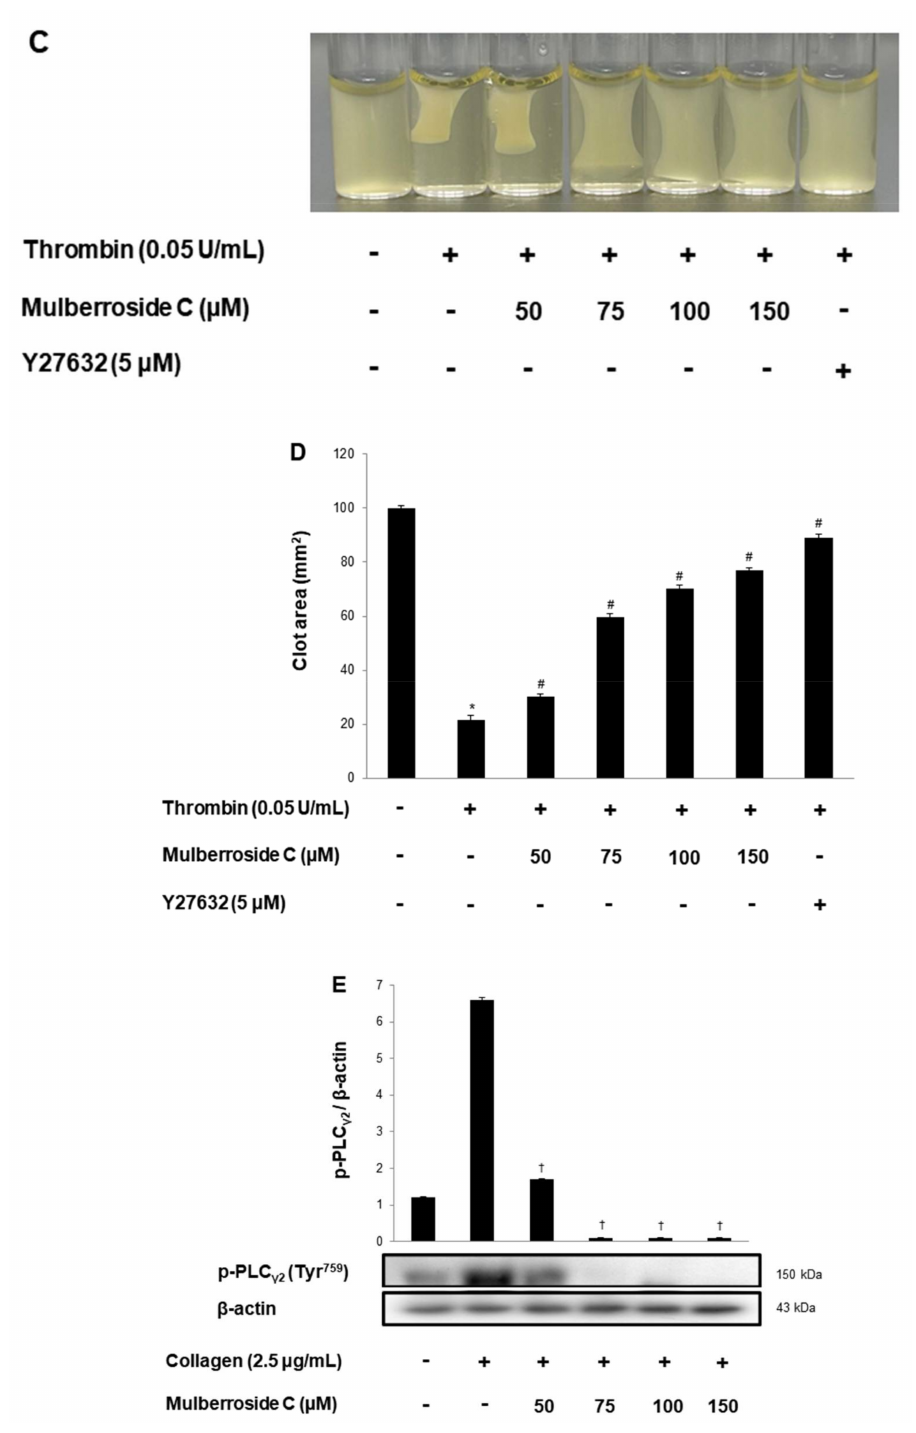
Figure 7. Effects of mulberroside C on cAMP and cGMP concentration, fibrin clot retraction, and PLC γ 2 phosphorylation; ( A ) Effect of mulberroside C on collagen-induced cAMP production; ( B ) Effect of mulberroside C on collagen-induced cGMP production; ( C ) Photographs of fibrin clot; ( D ) Effects of mulberroside C on thrombin-retracted fibrin clot (%); ( E ) Effect of mulberroside C on collagen-induced PLC γ 2 (Tyr759) phosphorylation. Quantification of fibrin clot retraction and Western blot, cAMP and cGMP was performed as describe in Section 2. The data are expressed as the mean ± standard deviation ( n = 4). * p < 0.05 versus the unstimulated human PRP, # p < 0.05 versus the thrombin-stimulated human PRP. † p < 0.05 versus the colla-gen-stimulated human